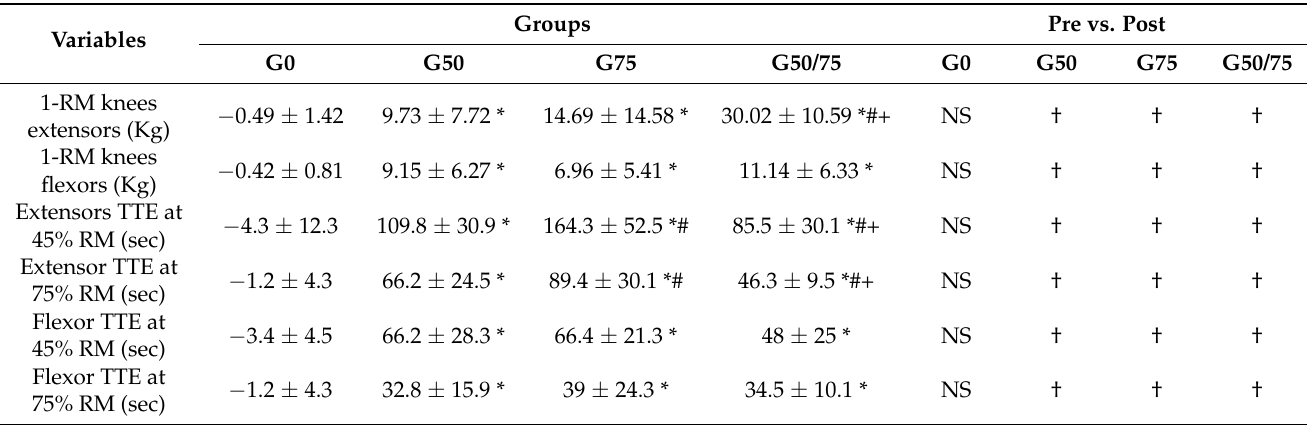
Table 5. Variation in 1-RM and time to exhaustion (TTE) at 45% and 75% RM for the knee flexors and extensors.